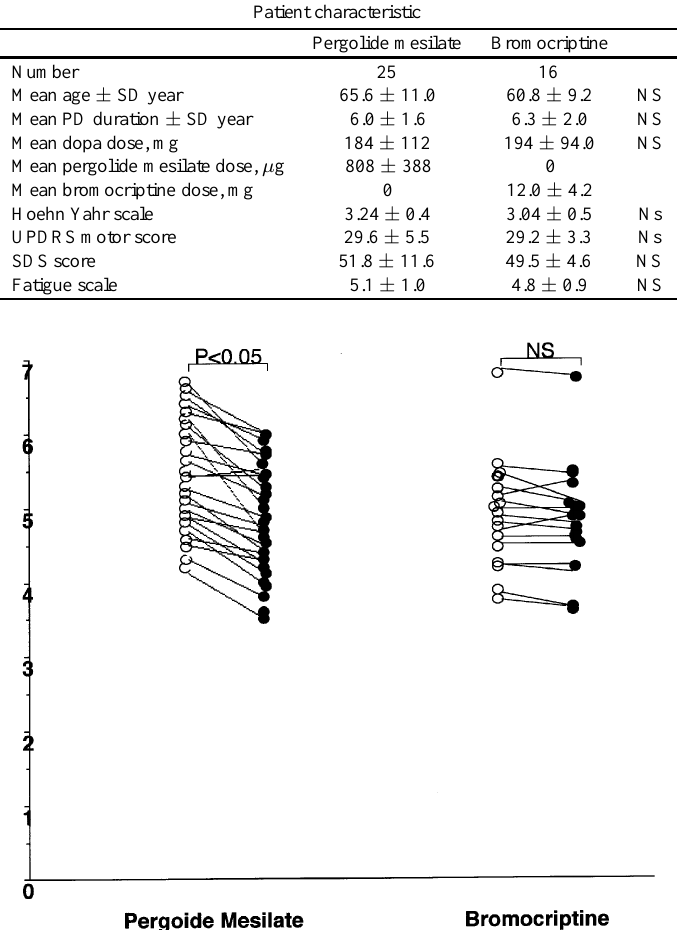
Fig. 1. Fatigue scale scores comparing those at baseline ( (cid:3) ) and after taking pergolide mesilate or bromocriptine ( • ). After taking pergolide mesilate or bromocriptine, patients taking pergolide mesilate showed significant improvement in the fatigue scale scores (from 5.1 ± 0.7 to 4.4 ± 0.55, p < 0 . 05 , left) in comparison to patients taking bromocriptine (from 4.8 ± 0.9 to 4.7 ± 0.8, NS,